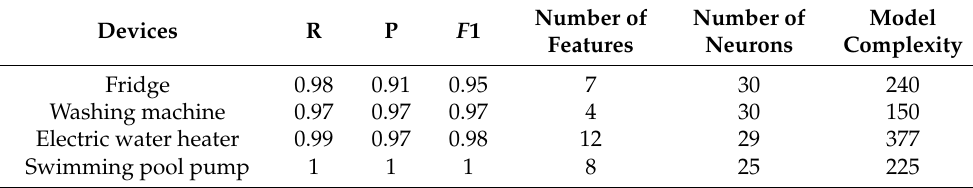
Table 7. Classification results.